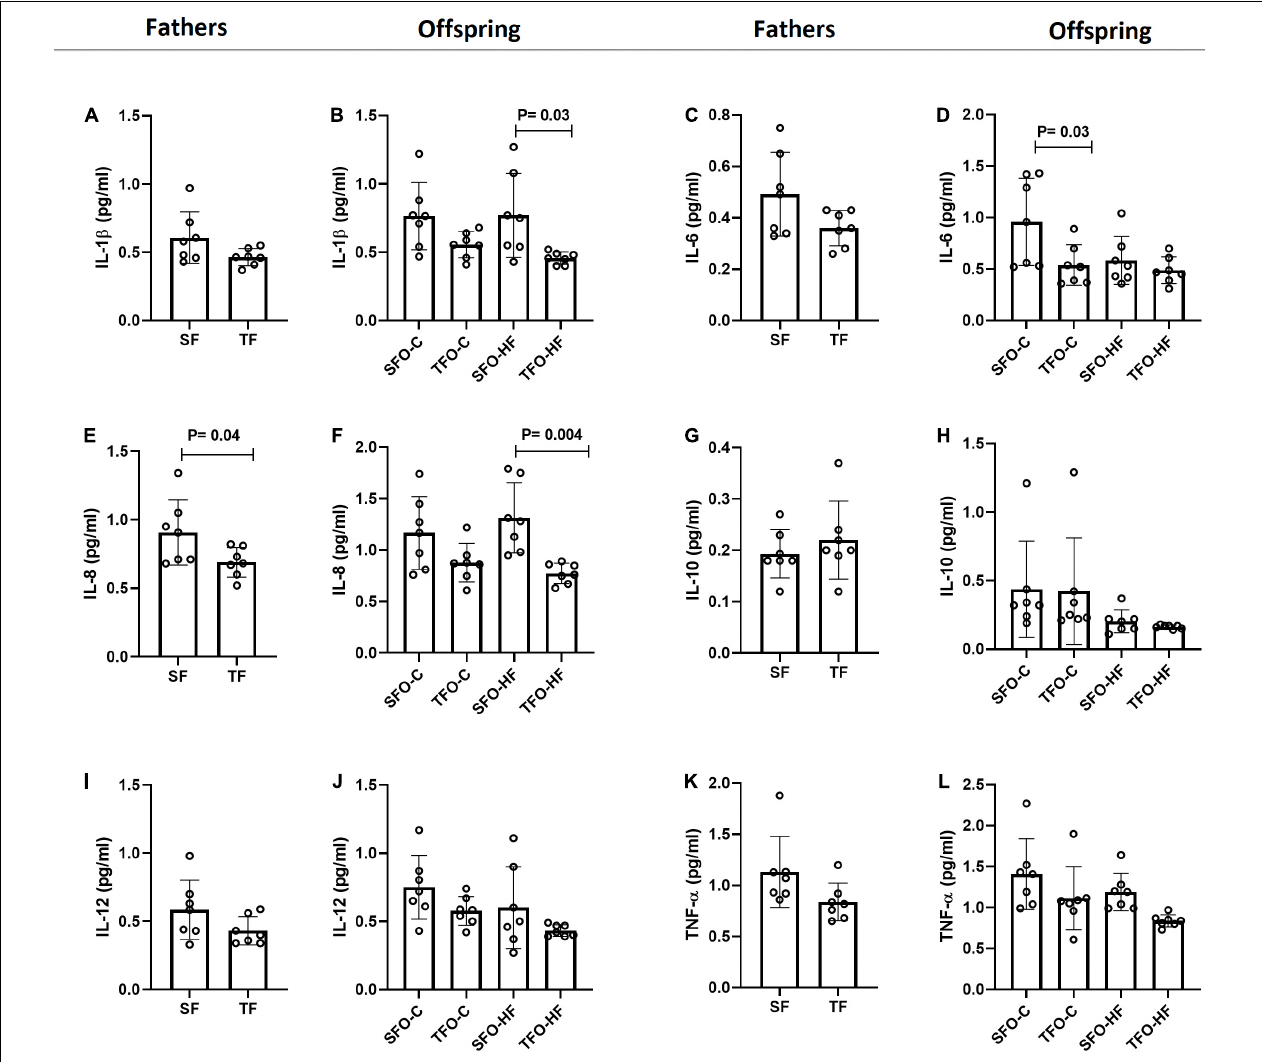
FIGURE 5 | Pro-inflammatory and anti-inflammatory cytokine levels in the gastrocnemius muscle of fathers and offspring exposed to control diet and HFD. The data are mean ± standard deviation. (A,B) Interleukin 1 β (IL-1 β ). (C,D) Interleukin-6 (IL-6). (E,F) Interleukin 8 (IL-8). (G,H) Interleukin 10 (IL-10). (I,J) Interleukin 12 (IL-12). (K,L) Tumor necrosis factor alpha (Tnf- α ). SF, sedentary fathers; TF, trained fathers; SFO-C, offspring from sedentary fathers, exposed to control diet; TFO-C, offspring from trained fathers exposed to control diet; SFO-HF, offspring from sedentary fathers exposed to high-fat diet; TFO-HF, offspring from trained fathers exposed to a high-fat diet ( n = 7 per